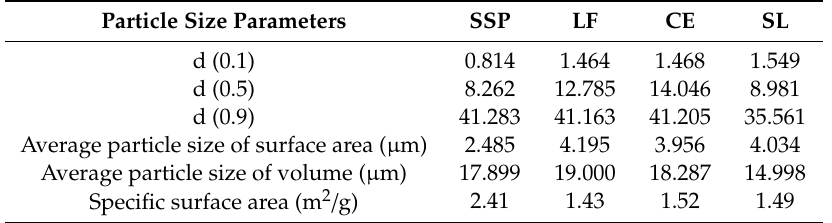
Figure 5. Particle size distributions of the four fillers. Table 4. Particle size parameters of the four fillers.